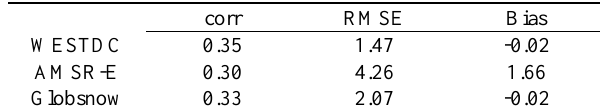
Table 3. The Confusion matrix for remote sensing image vs. snow depth